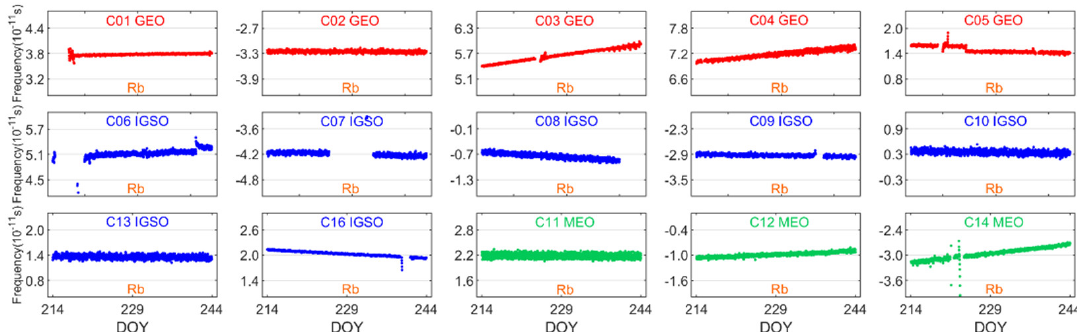
Figure 7. Frequency series of BDS-2 satellites.